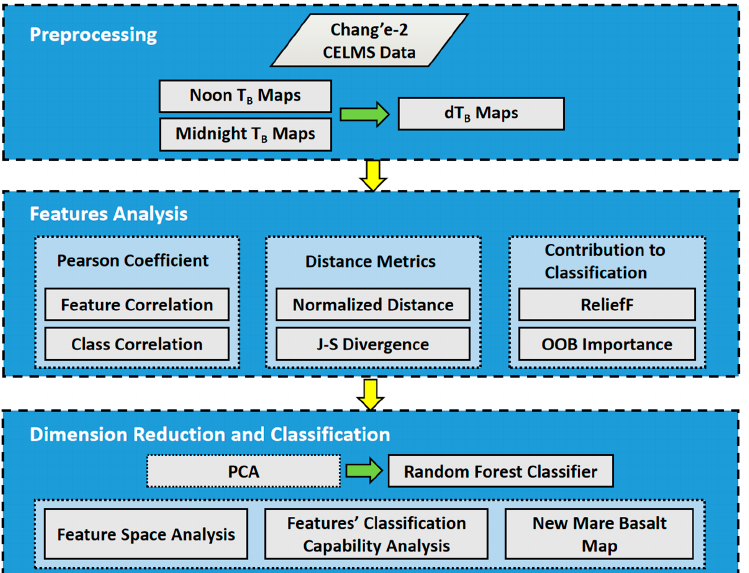
Figure 5. Overall framework.